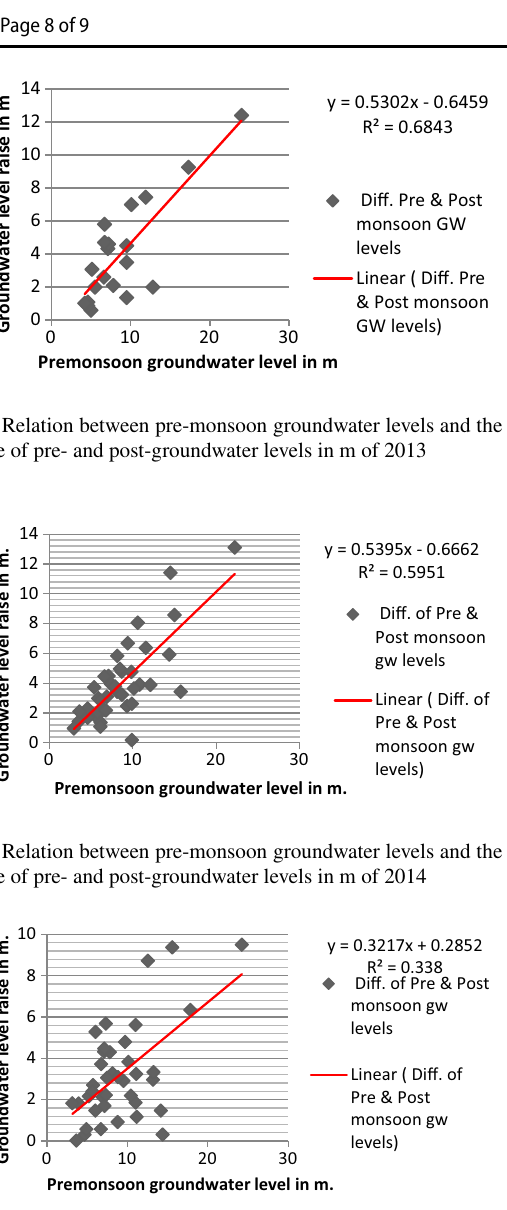
Fig. 8 Relation between pre-monsoon groundwater levels and the dif- ference of pre- and post-monsoon groundwater levels in m of 2015